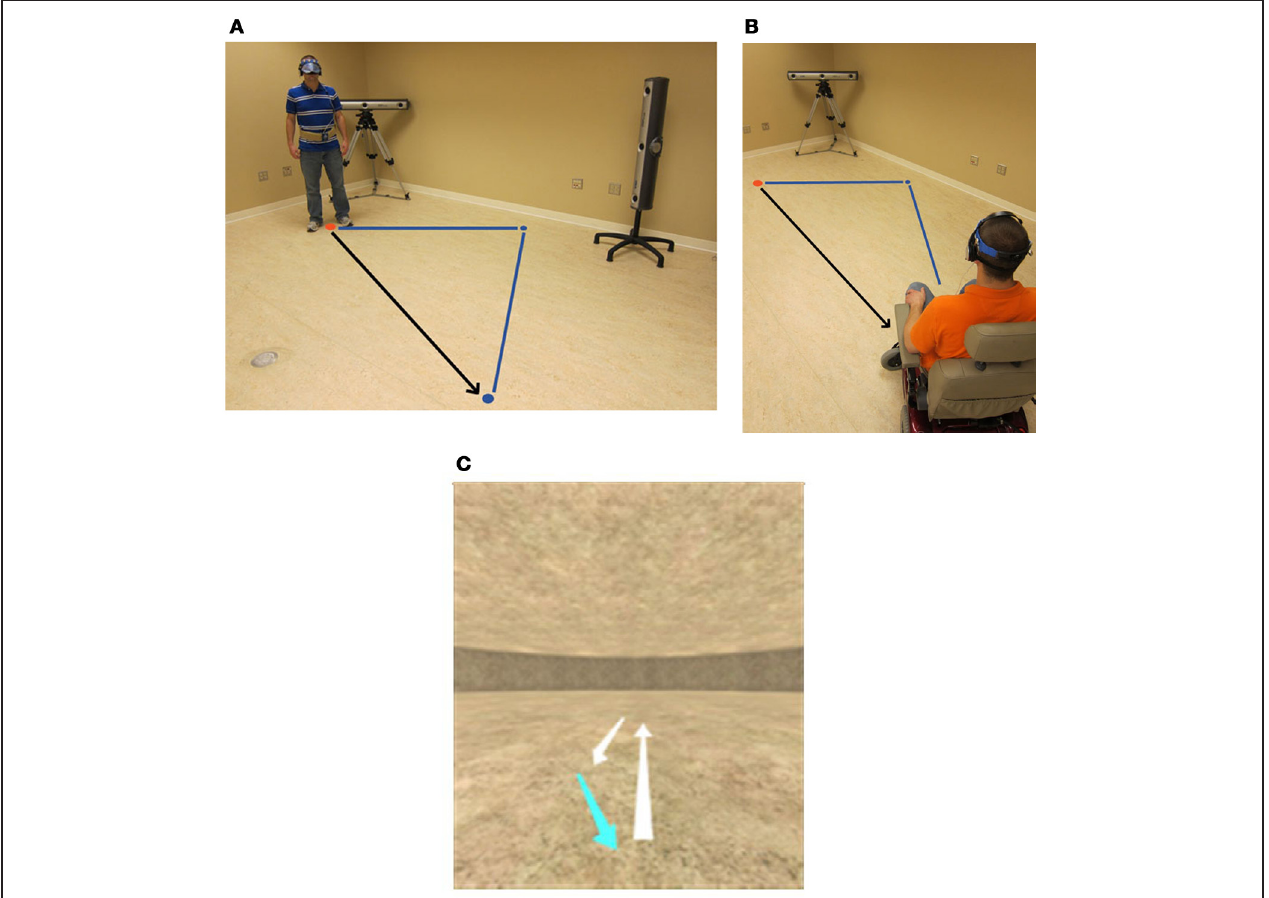
condition consisted of passively viewing a movement trajectory on a computer monitor (C) then moving a joystick when responding to the active portion of the task. Guided movements (lighter shaded lines) and participants movements (darker shaded lines) are shown on the schematic.